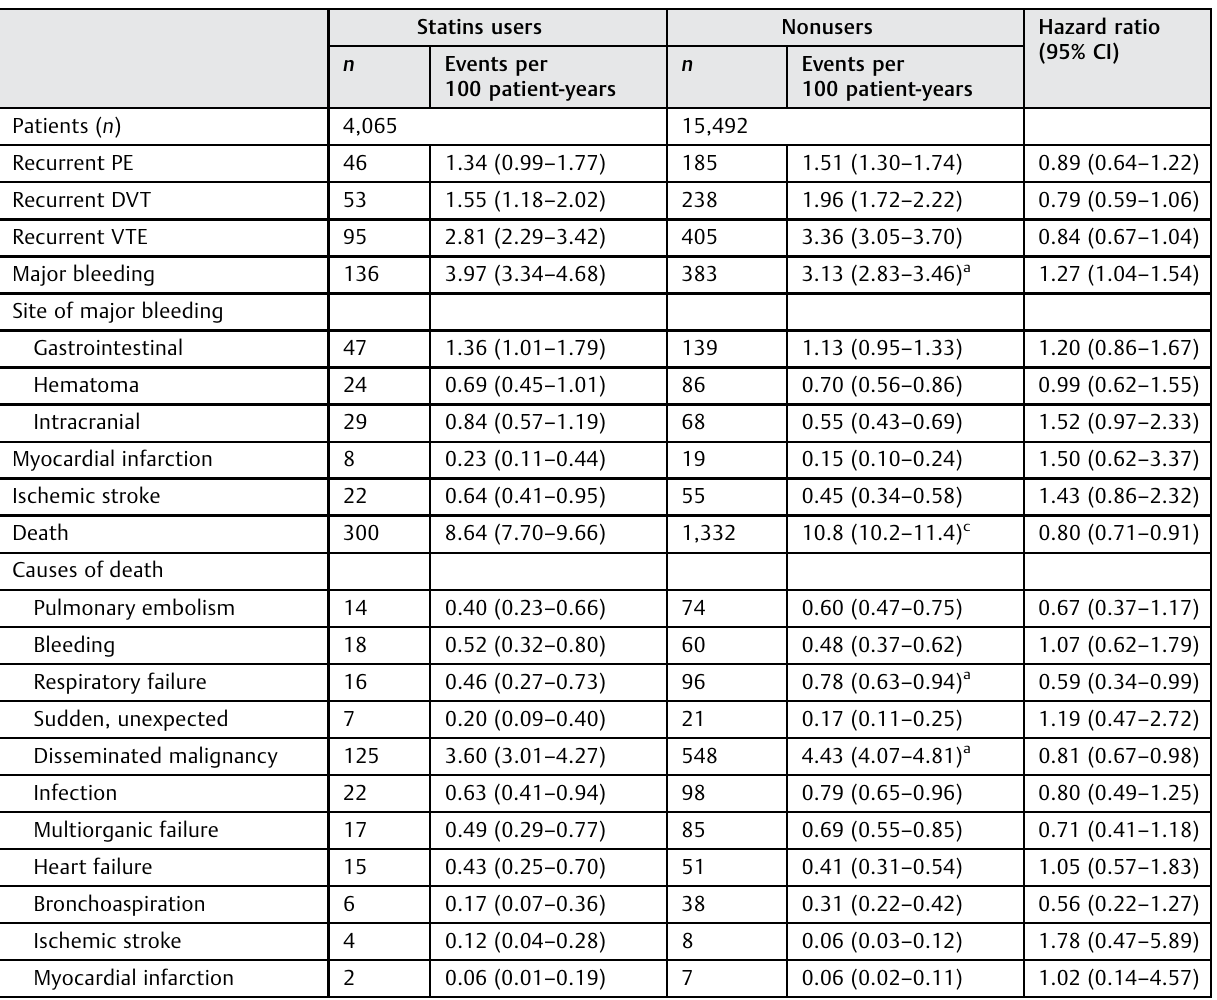
Table 3 Clinical outcomes during the course of anticoagulant